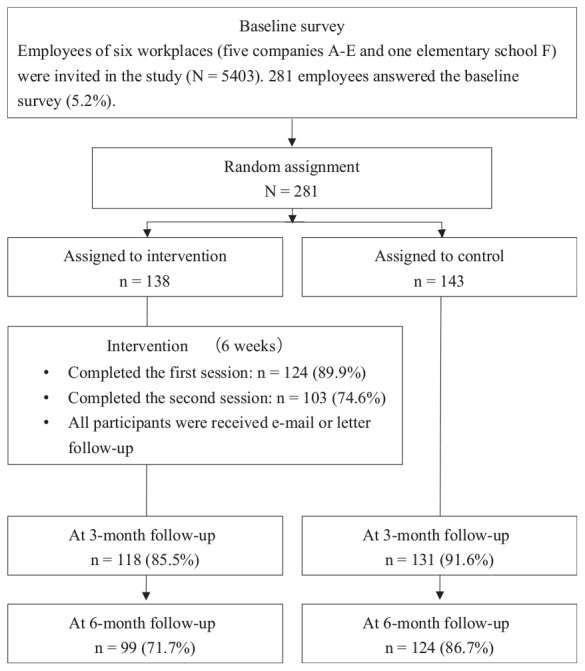
Participant flowchart.